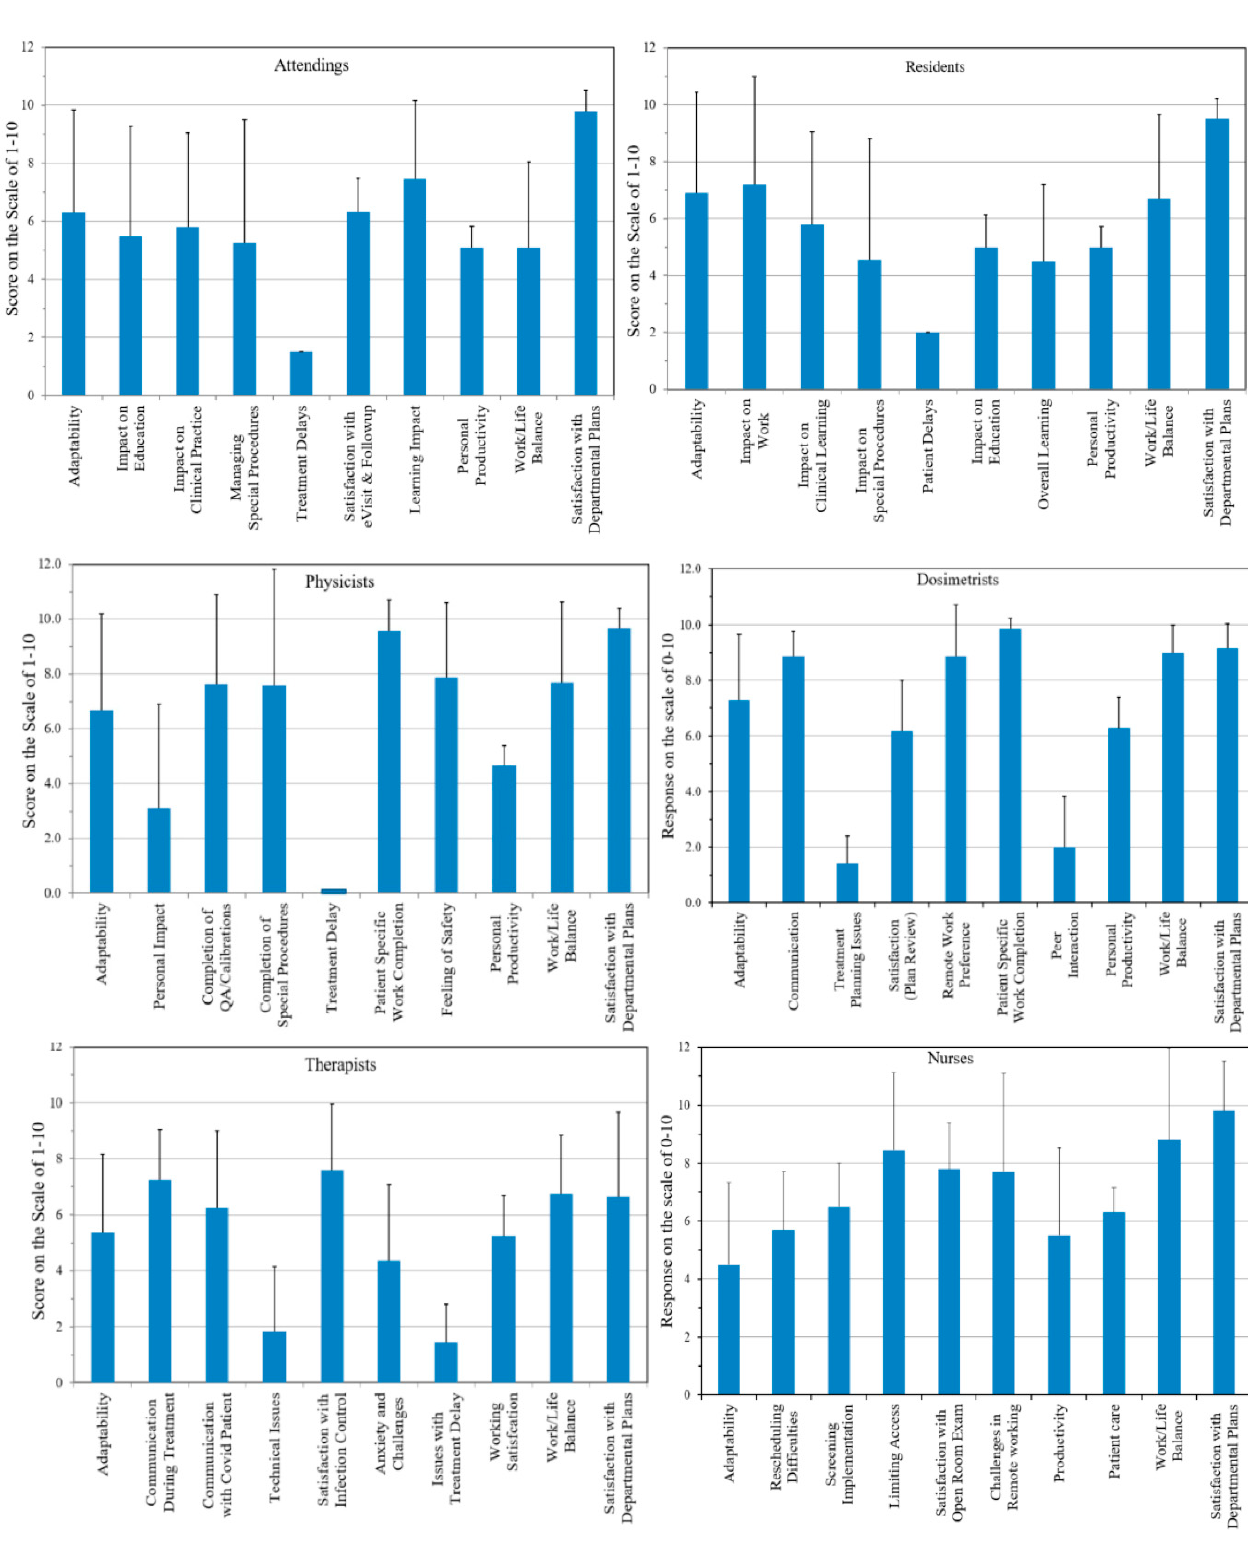
Figure 1. Questionnaire responses from each section of the department. Questions in each group are not identical.